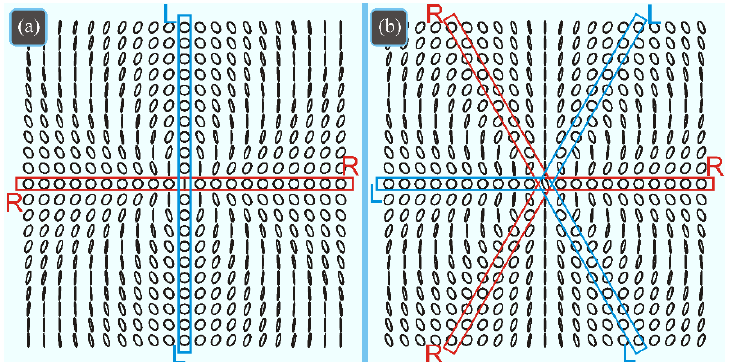
Figure 4. Jones vectors for hybrid vector field with parameter a = 1 at ( a ) n = 2 and ( b ) n = 3. Regions of circular polarization (C-lines) are marked with rectangles. Letters R and L denote regions with right- and left-hand circular polarization.